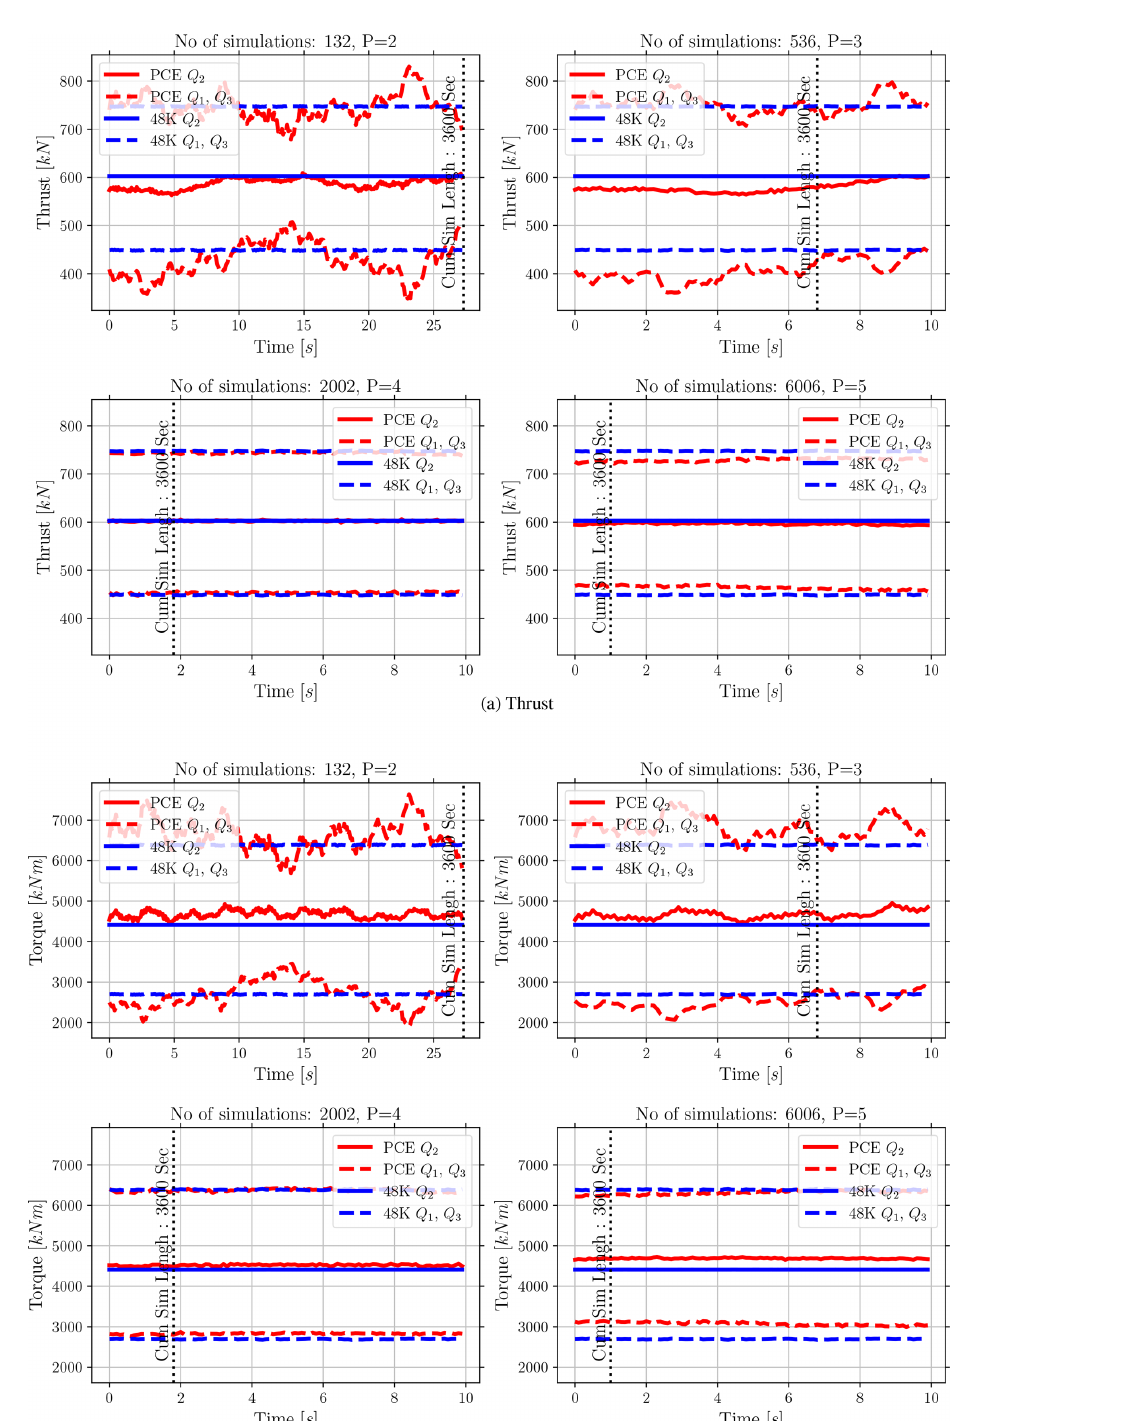
Figure 4. The Q 1 , Q 2 , and Q 3 comparison from the reference case (48000 simulations) and extracted values from PCEs for both thrust and torque. The number of simulations used to build the PCEs and polynomial degree P are mentioned on the plots. The cumulative data length of 3600s sufficient to build surrogates is shown with the vertical